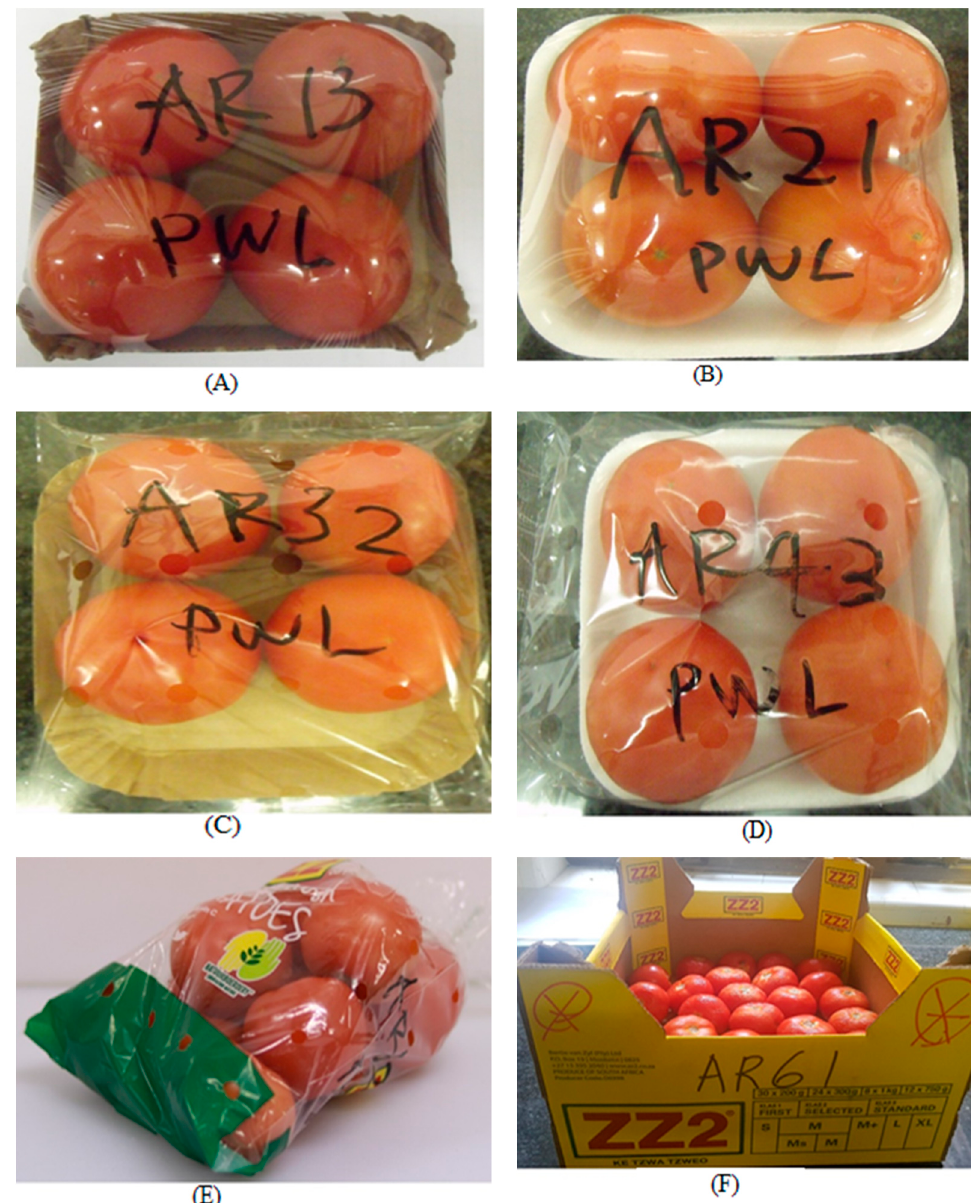
Figure 1. Round tomato packaging treatment: ( A ) SP Tray + PVC wrap, ( B ) EPS Tray + PVC wrap, ( C ) EPS Tray + Flow wrap, ( D ) SP Tray + Flow wrap, ( E ) 1 kg PP bag, and ( F ) Unpackaged (Control).